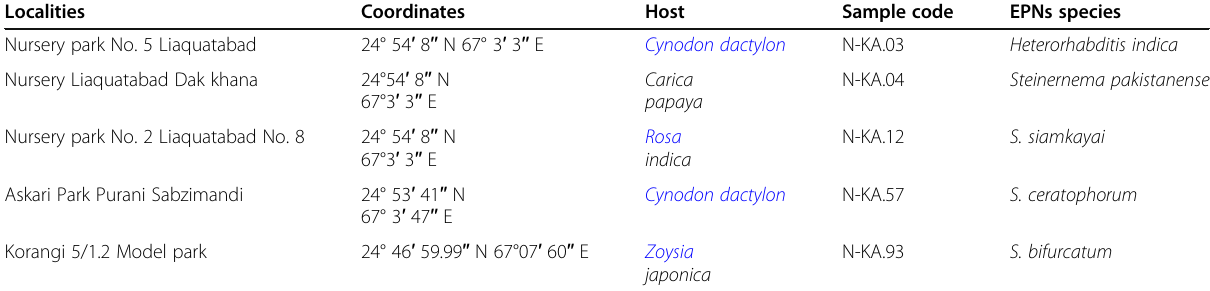
Table 1 Surveyed localities and host for collection of entomopathogenic nematodes Localities